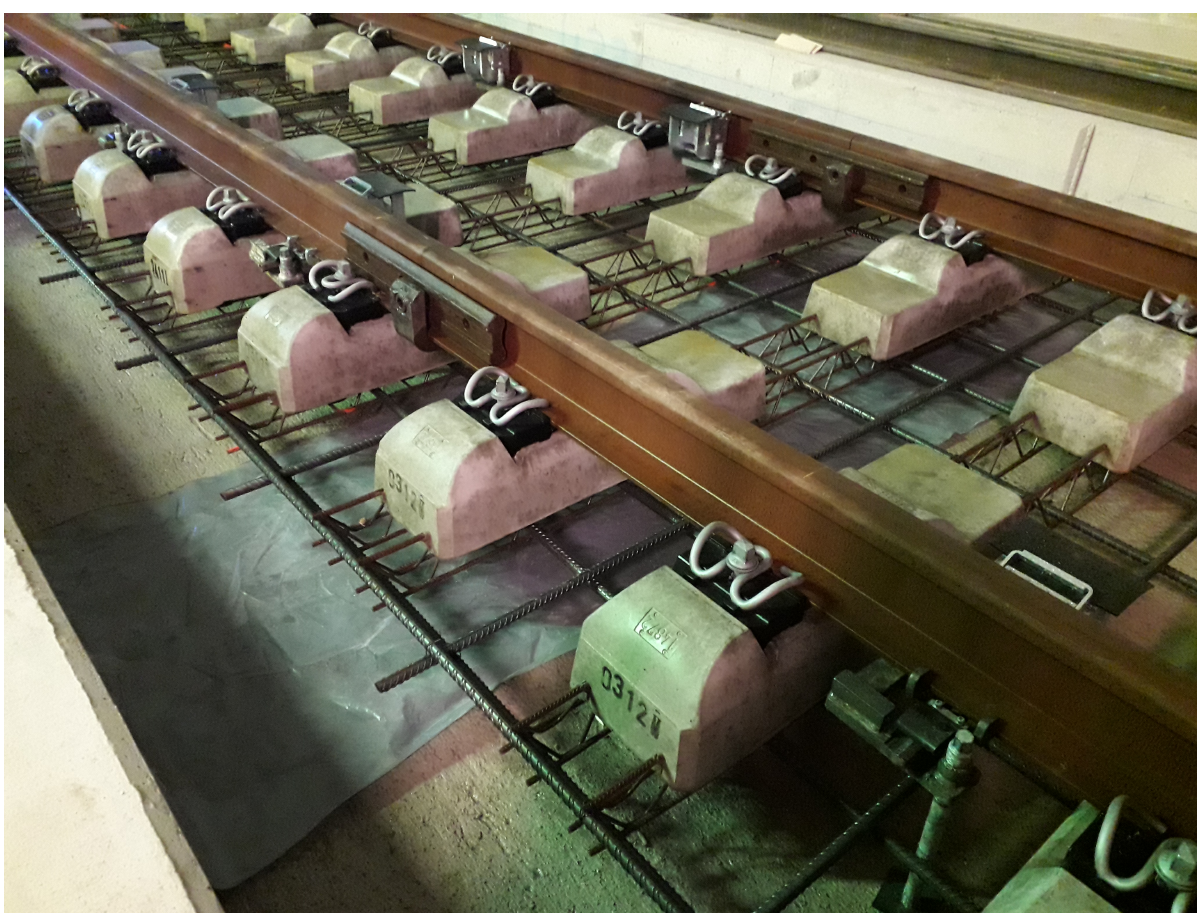
Figure 1. Ballastless track type RHEDA 2000 before casting (by concrete), photography author: DB Projekt Stuttgart-Ulm GmbH/Ondřej